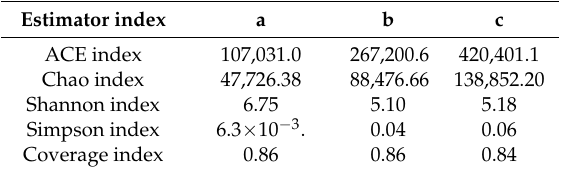
Table 4. Microbial community richness and alpha diversity in seed sludge (a), domesticated sludge of the ASBR reactor (b), and domesticated sludge of the biofilter